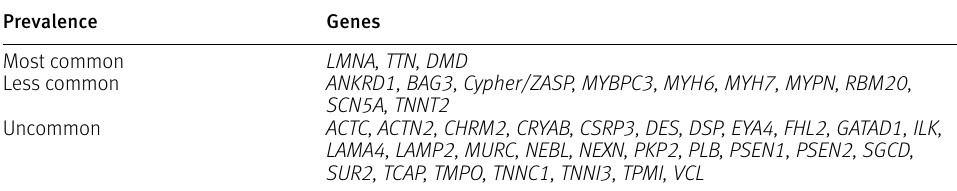
Table 1. Disease genes associated with adult-onset DCM.